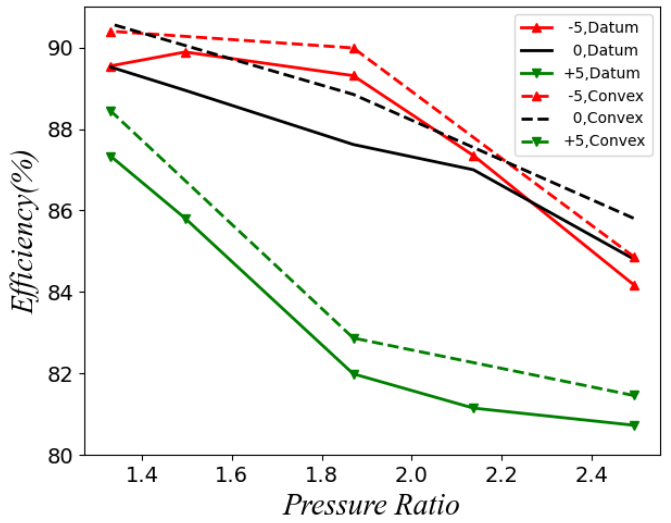
Figure 10. Efficiency versus pressure ratio, at the designed speed.